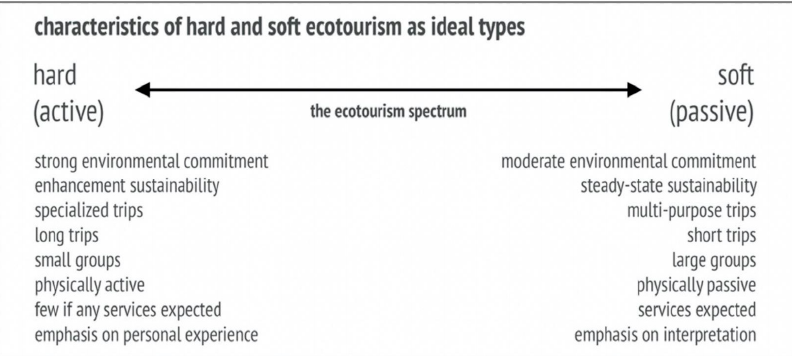
Figure 1. Characteristics of hard and soft ecotourism as ideal types (Source: compiled by the author based on [13]).